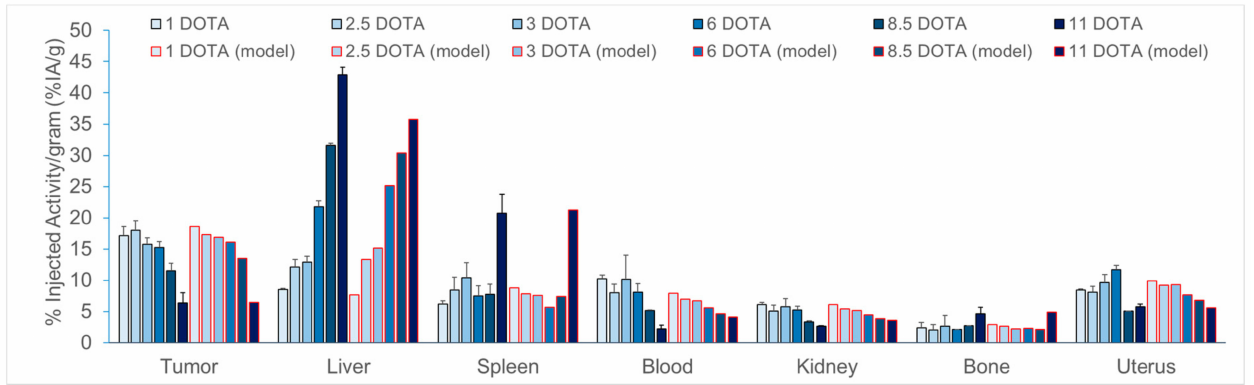
Figure 3. Comparison between the results obtained by biodistribution (in grey) and pharmacokinetic modeling (in red) at 24 h for [ 177 Lu]Lu-1C1m-Fc conjugated with 1 to 11 DOTA in Balb/c nu mice bearing TEM-1 positive